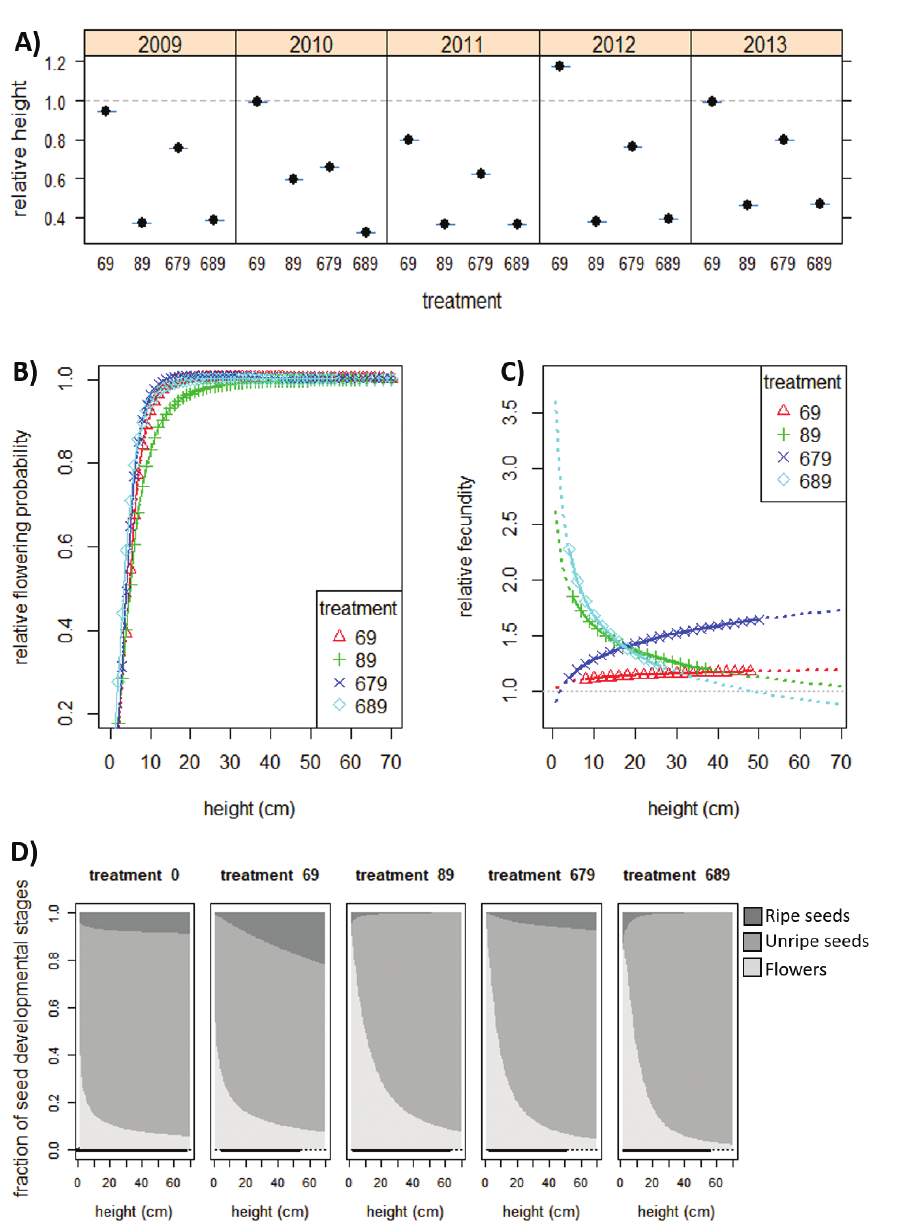
Figure 2. Fitted effects of experimental mowing treatments on vital rates. Experimental mowing treatments are indicated by their code (69, 89, 679, 689, see Table 1) and figures present fitted effects on A ) mean plant height in September per year, B ) flowering probability, C ) fecundity and D ) the development of seeds (see details of statistical models in main text and Suppl. material 1). Suppl. material 1 Effects in A–C are rela- tive to that of the control treatment (0) and for B–D across all years as a function of the back-transformed covariable plant height in September. Dotted ends of lines in C and of the horizontal line at the bottom of D indicate where models were extrapolated beyond the range of observed plant height